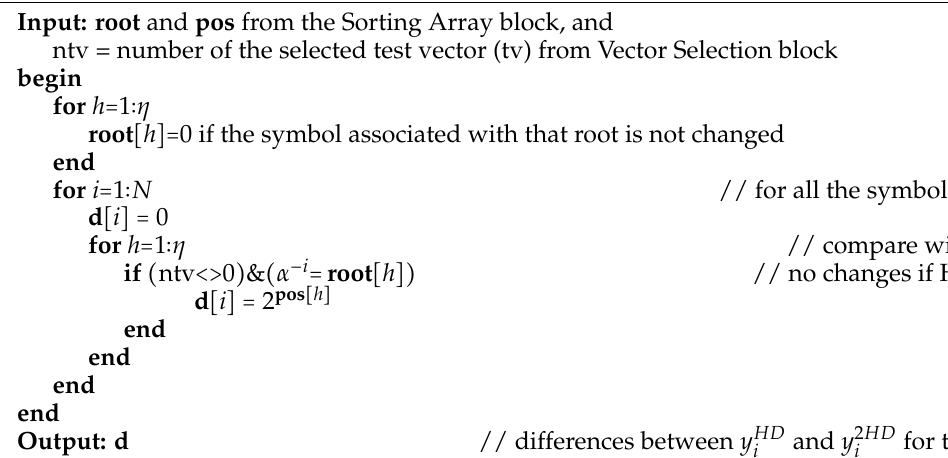
Algorithm 3 Pseudocode for the Symbol Modification block